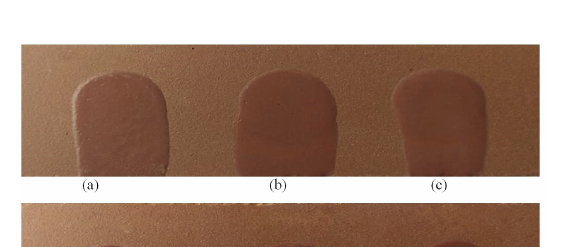
Figure 8. Application of pigments in ceramics: (A) PAZC33 (B) PAZC33 (F) PAZR33 (J) PAZR33 (M) PAZC33 (Q) PAZR33 names refer to replicate